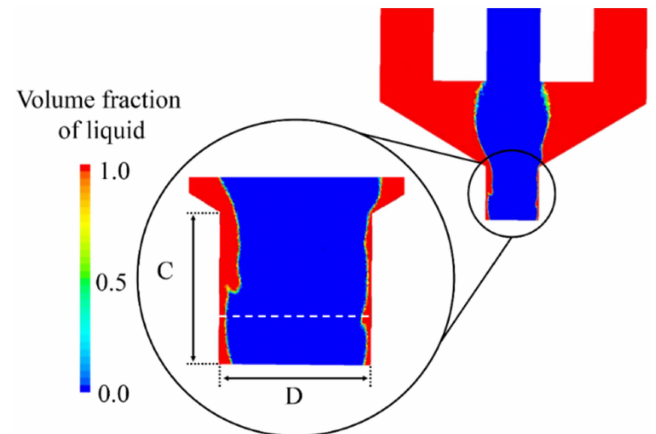
Figure 7. Exemplary 2D section of the nozzle geometry with simulated volume fraction of liquid. For comparison of time dependent liquid film thicknesses with optical measurements, a line probe (close up view; white dashed line) was used (cf. Figure 3). Additionally, length ( C ) and diameter ( D ) of the exit orifice, are indicated (cf. Figures 1 and